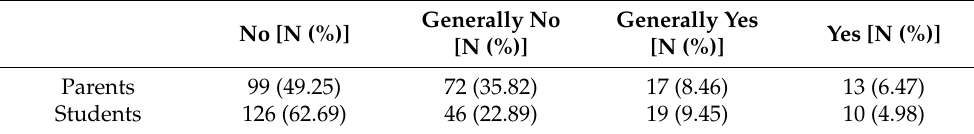
Table 8. Wearing of protective masks when